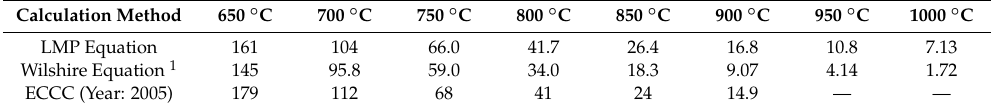
Table 12. Calculated creep strength for rupture at 100,000 h (MPa) of Inconel 617.